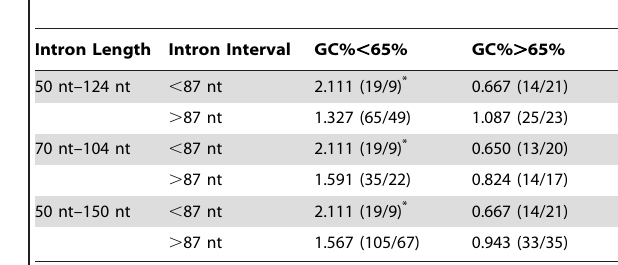
Table 5. RDI (DAF , 0.1) when examining dependence of GC- effect on intron length.